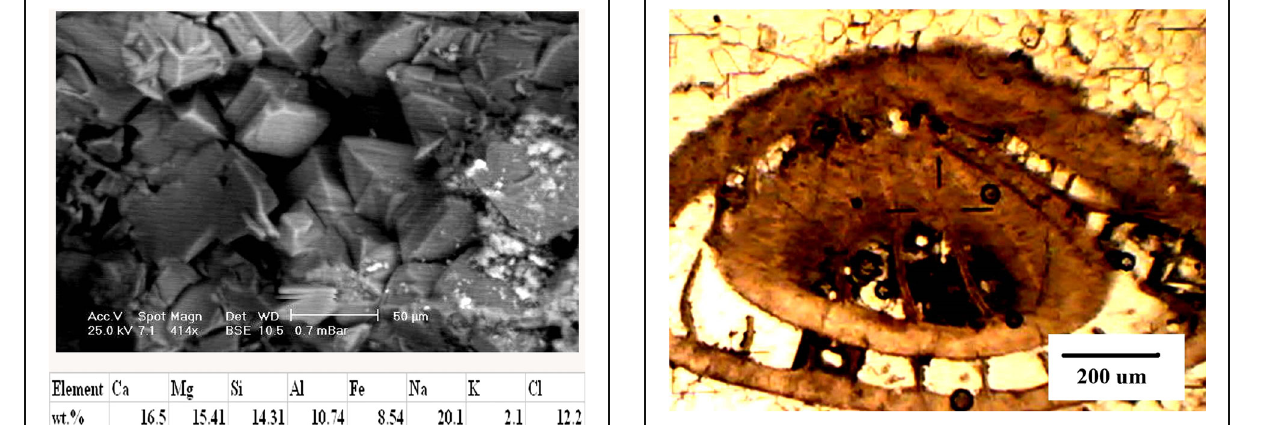
Fig. 5 Nummulitic biomicrite (wackestone/mudstone) microfacies showing Nummulite discorbinus embedded in sparite matrix and dissolution, PPL